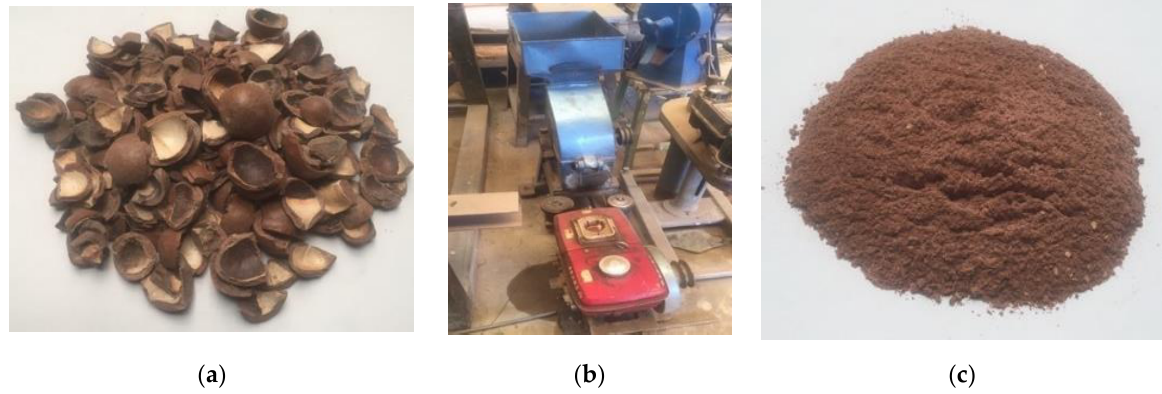
Figure 1. ( a ) Macadamia nutshell, ( b ) R170 diesel engine, ( c ) macadamia nutshell particle size between 0.3 mm and 2.36 mm.